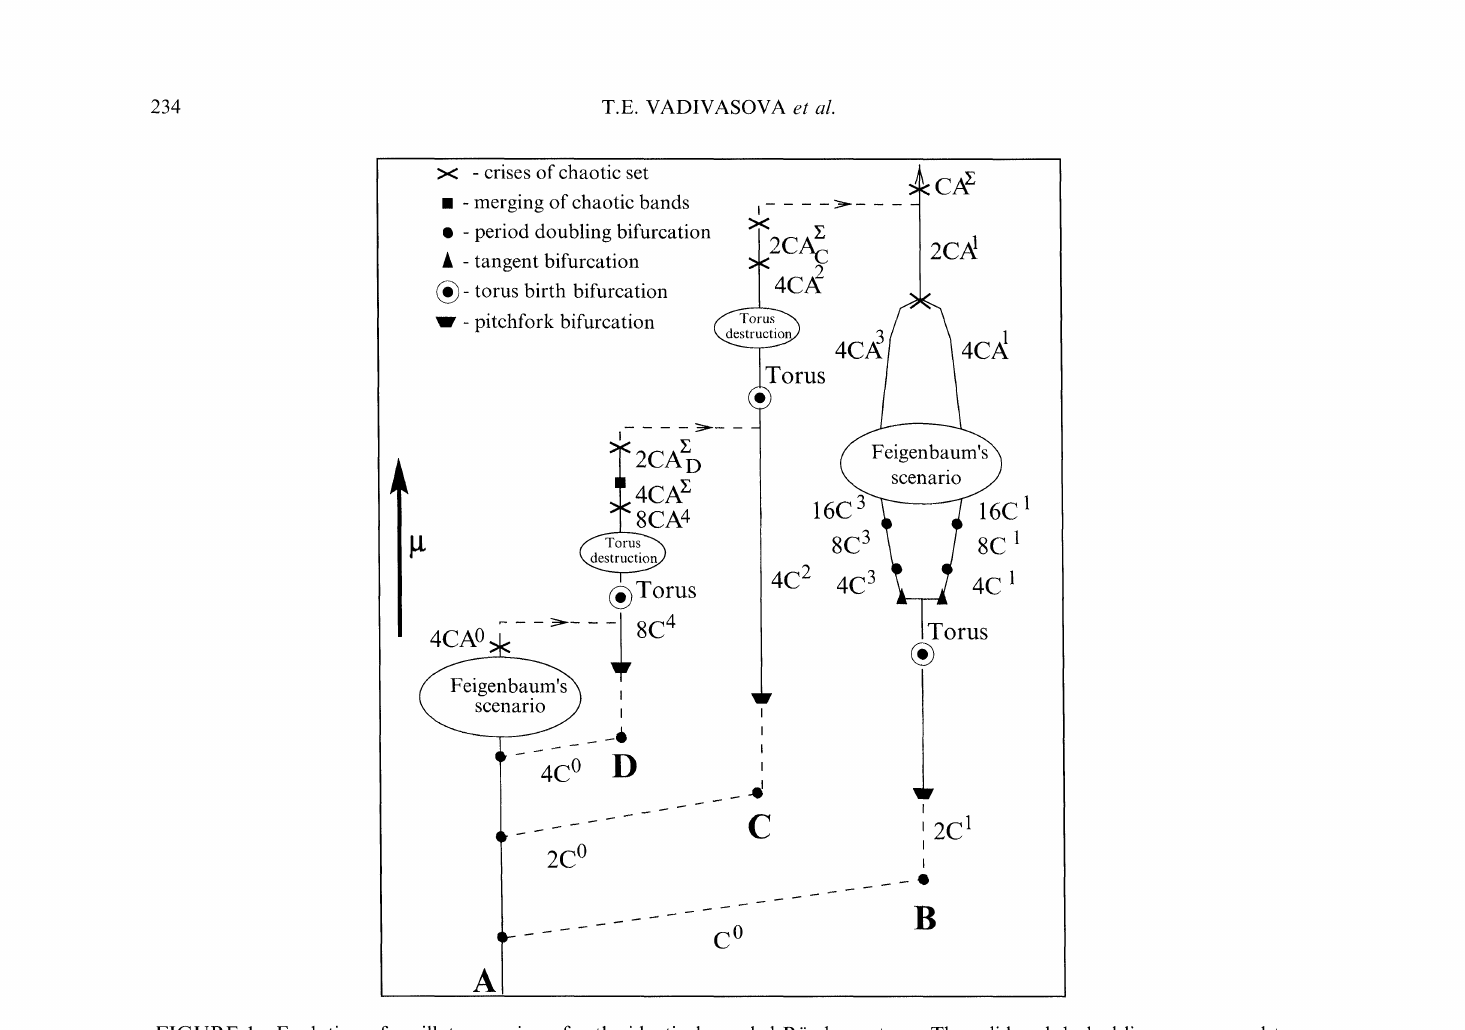
FIGURE Evolution of oscillatory regimes for the identical coupled R6ssler systems. The solid and dashed lines correspond to bifurcational transitions of attractive and saddle solutions,